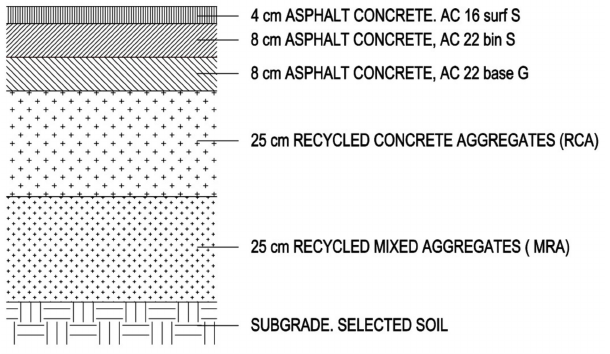
Figure 6. Cross sections of the port